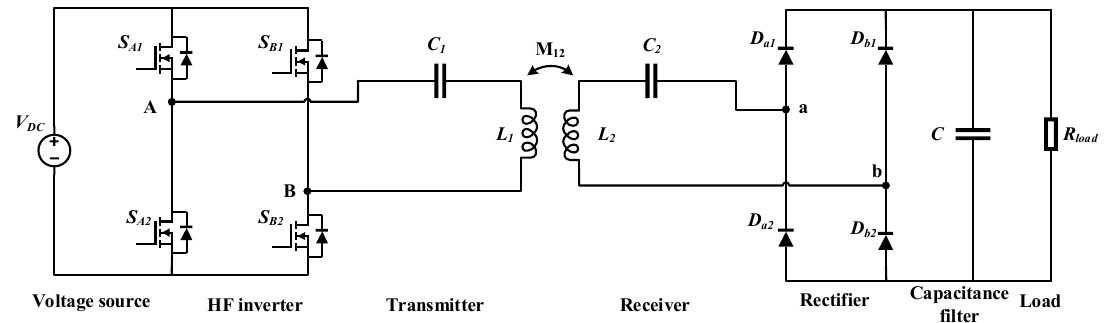
Figure 1. Typical wireless power transfer (WPT) system with a series-series (SS) compensation topology. Using the fundamental harmonic approximation (FHA) method to analyze the circuit, a simplified equivalent circuit is shown in Figure 2. The square wave voltage provided by the HF inverter is approximated by a fundamental-harmonic pure sinusoidal input voltage source, and the high-order harmonics are neglected. The rectifier and load R load can be seen as an equivalent alternating current (AC) load resistor R L , where R L = R load × 8/ π 2 [53].